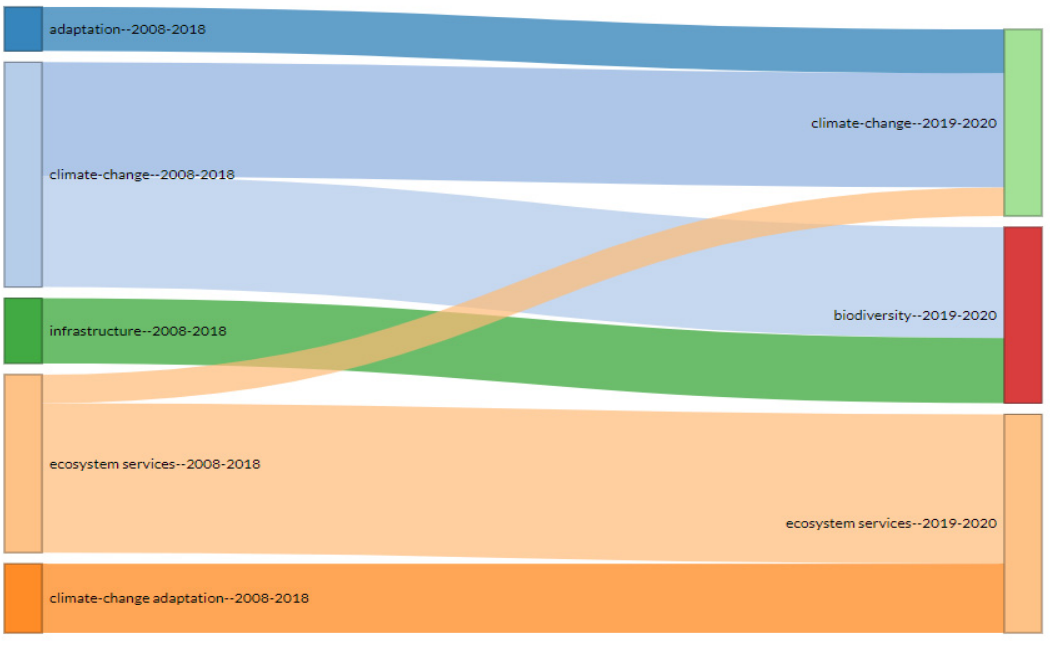
Figure 7. Topic Evolution by Keywords Plus. Source: Biblioshiny. Own compilation.